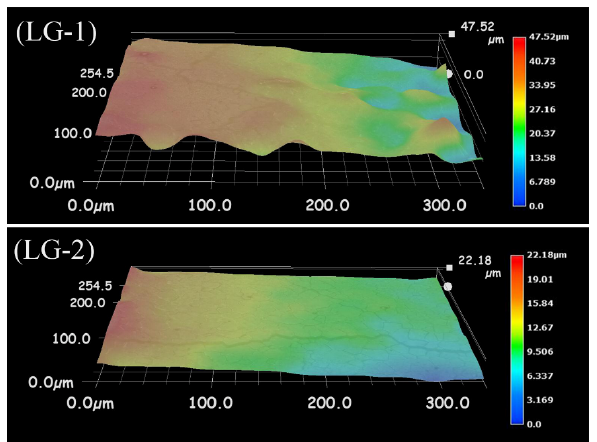
Fig. 3 Three-dimensional morphologies of the laser-glazed coatings (LG-1 and LG-2).